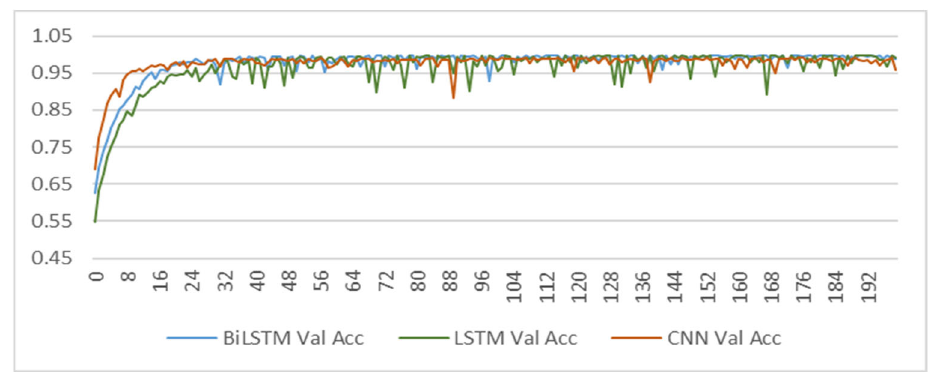
Figure 9. Accuracy graphs of the validation datasets.